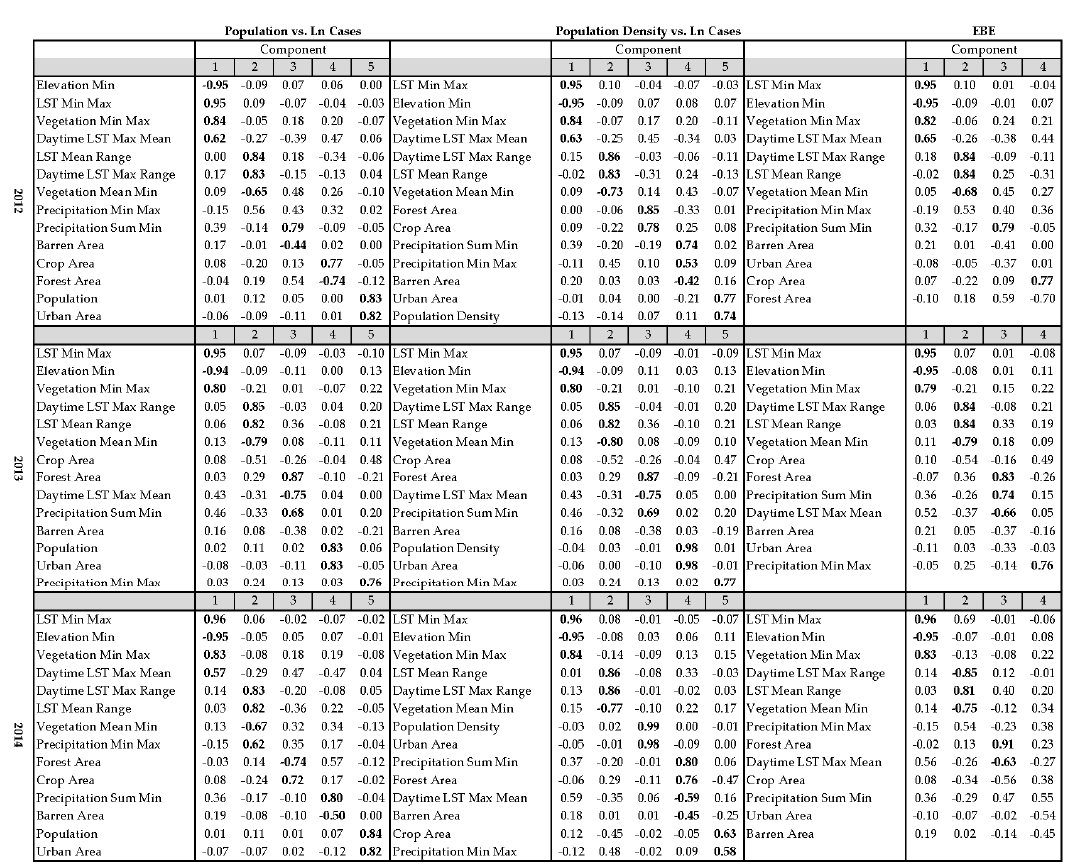
Figure 3. Model output of principal component loadings. The strongest component loading was bolded for each variable.